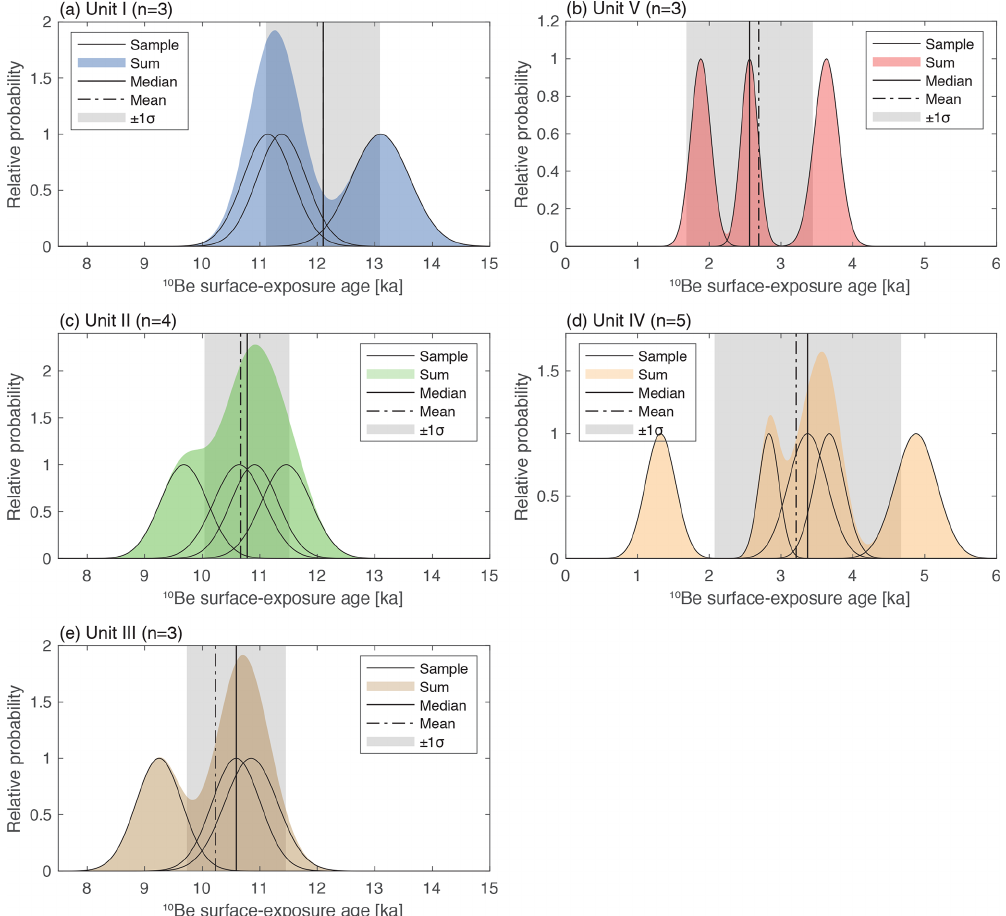
Figure A4. Probability distributions of the 10 Be surface-exposure ages for individual samples with sum, mean, median, and standard devia- tion given for each unit.